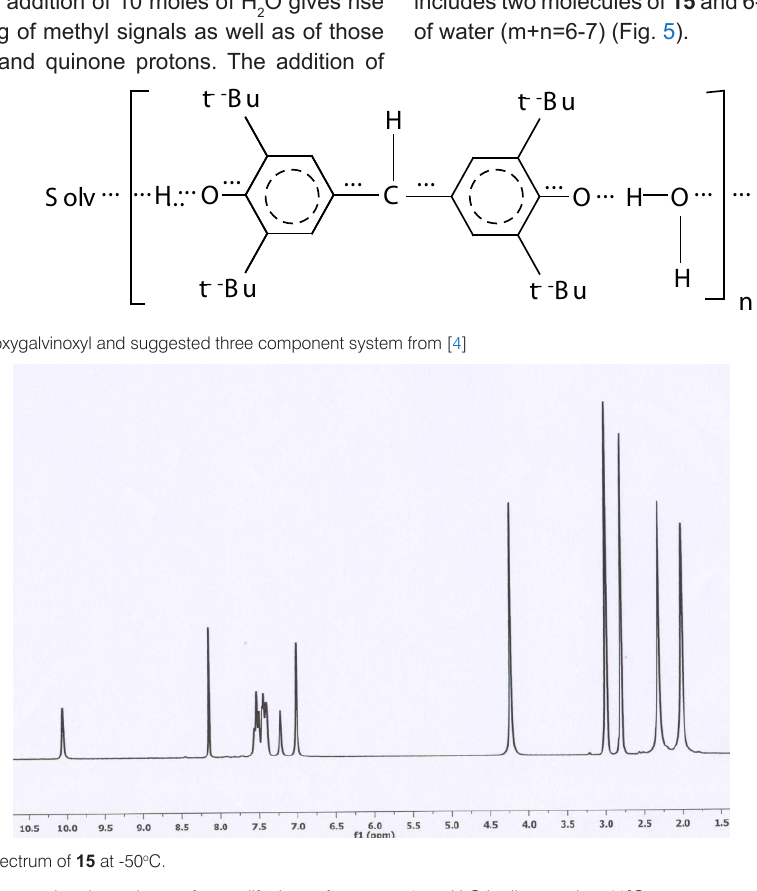
O in dioxane-d at 20 0 C 2 8